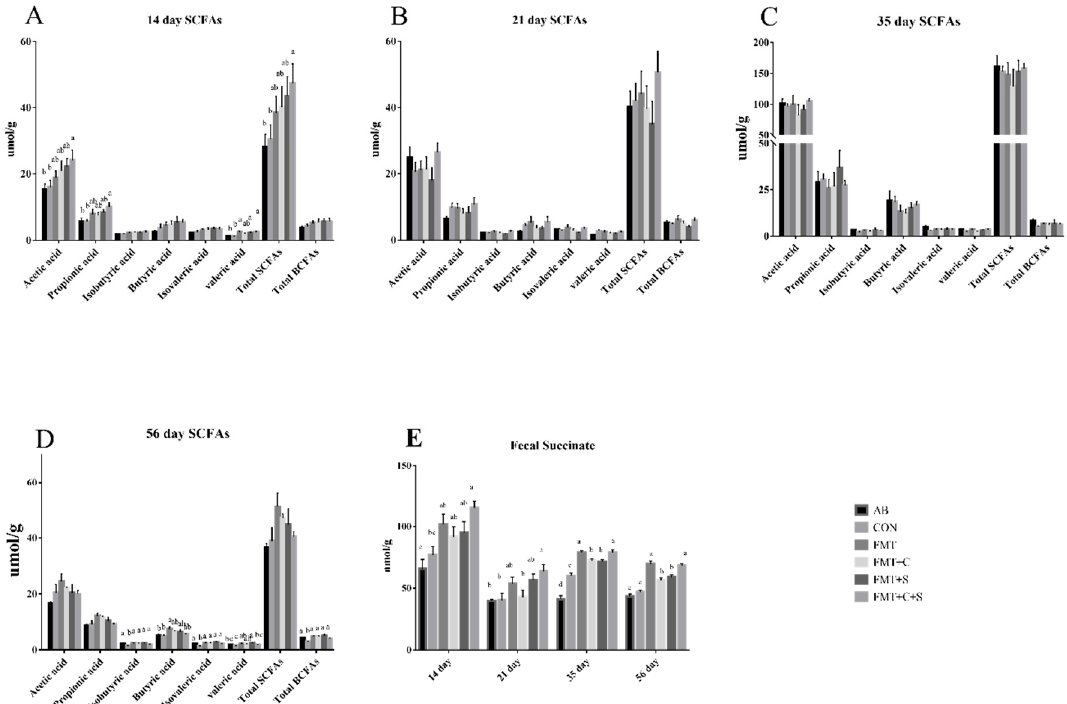
Figure 1. E ff ects of di ff erent early intervention model on the fecal bacterial metabolites in piglets. Fecal short-chain fatty acid (SCFA) concentrations of piglets at the age of 14 d, 21 d, 35 d and 56 d ( A – D ) were determined, Succinate concentration in fecal at the age of 14 d, 21 d, 35 d and 56 d ( E ). All values are presented as means ± standard error of the mean (SEM, n = 10–12). a,b,c Values within a row with di ff erent superscripts di ff er significantly at p <